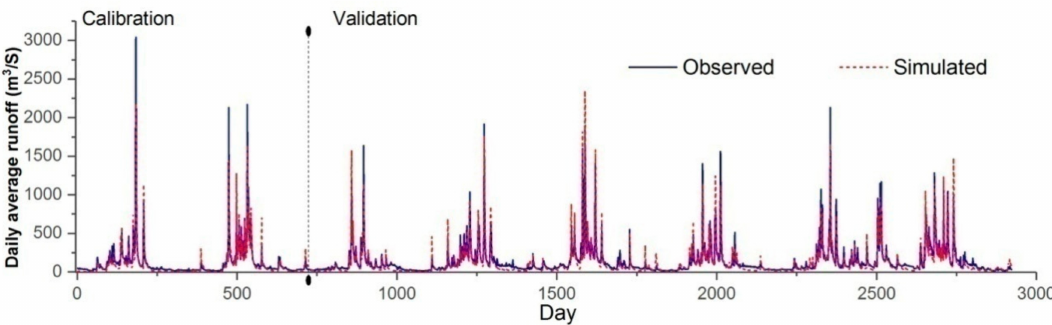
Figure 4. Comparison of daily runoff using